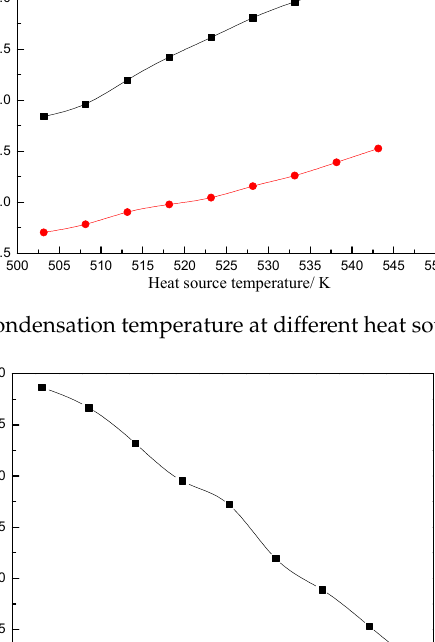
Figure 13. Turbine efficiency at different heat source temperature. Appl. Sci. 2018 , 8 , x FOR PEER REVIEW